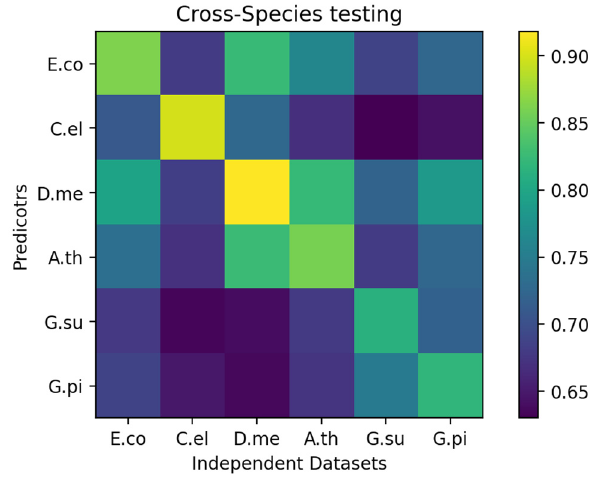
Figure 10. The heatmap of the predictors for six species in cross-species testing.